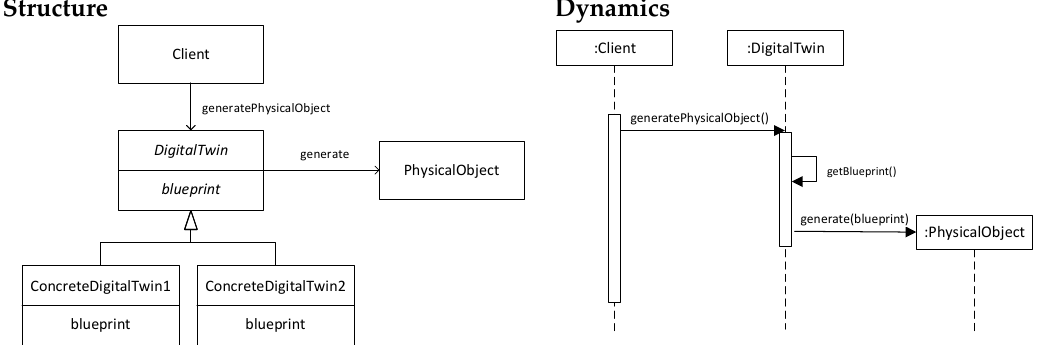
Figure 8. Digital Generator pattern.